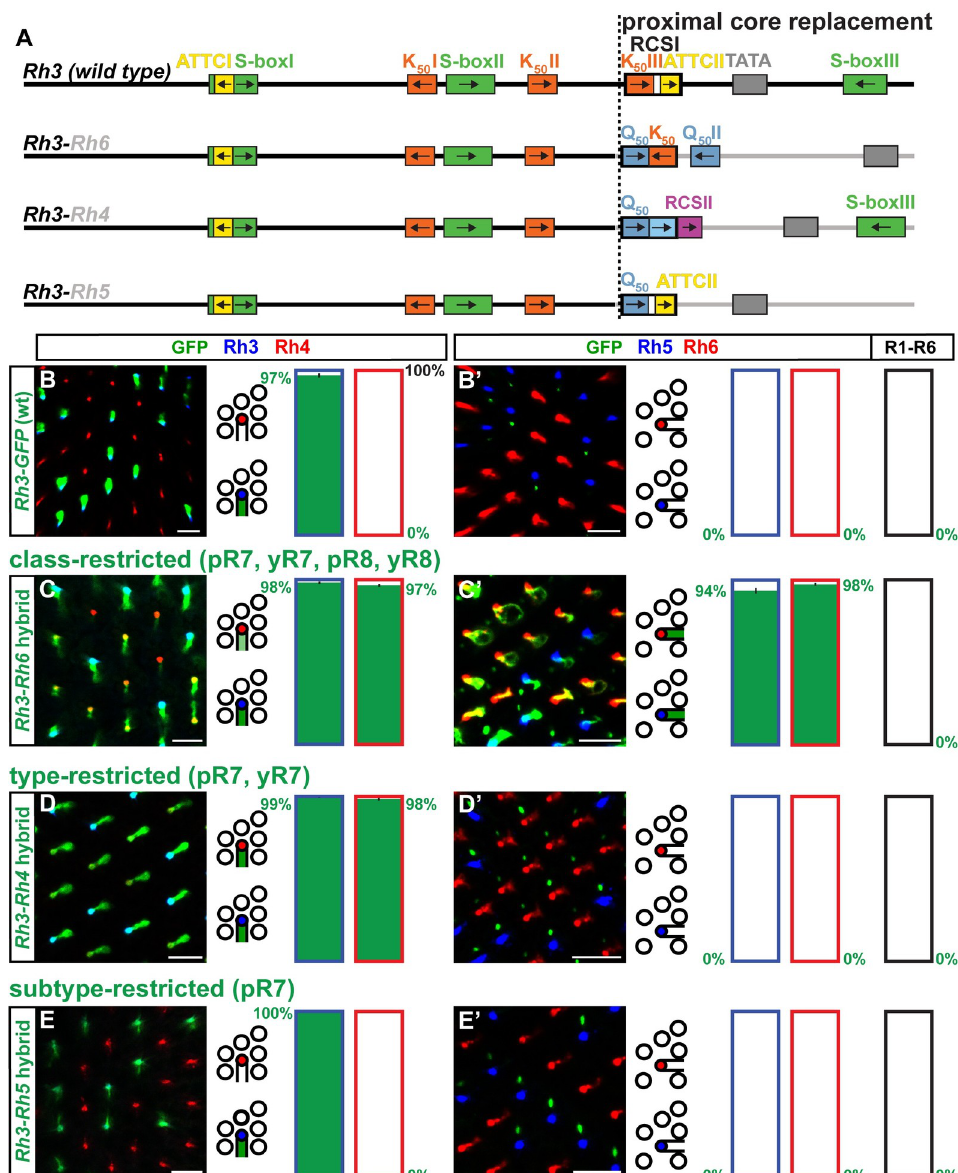
Fig 6. Novel motif combinations yield a series of progressively restricted expression patterns. (A) Schematic comparison of wild type Rh3 promoter and hybrids of the distal Rh3 promoter combined with the proximal core promoters of Rh4 , Rh5 , or Rh6 . Note in the proximal region the shared K 50 motif within the Rh6 RCSI and the ATTCII motif at the same position within the Rh5 RCSI, as well as the same spacing of the Rh5 RCSI and the TATA box. The dotted vertical line indicates the break/fusion point of the hybrids. (B)—(E) Wild type vs . hybrid promoters driving GFP reporter expression (green) in the R7 layer. Rh3 (blue) labels pR7s and Rh4 (red) labels yR7s. Bar graphs show GFP co- expression in the Rh3 or Rh4 subset, respectively. (B’)—(E’) Wild type reporter vs . hybrid promoter driving GFP reporter expression (green) in the R8 layer. Rh5 (blue) labels pR8s and Rh6 (red) labels yR8s. Bar graphs show GFP co- expression in the Rh5, Rh6, or R1-R6 subset. Green numbers indicate the mean percentage of GFP co-expressing photoreceptors, error bar represents standard error of the mean. (B) and (B’) The wild type Rh3 promoter drives subtype-specific GFP expression in the pR7/Rh3 subset. Green staining in (B’) is from the axons of pR7s that traverse the R8 layer. N = 18 retinas and n = 1,188 R7s for (B); N = 11 retinas, n = 958 R8s and 5,748 R1-R6 PRs for (B’). (C) and (C’) The Rh3 - Rh6 hybrid drives photoreceptor class-restricted GFP expression in all ‘inner’ photoreceptors, i.e. both the R7 and R8 photoreceptor types (pR7s, yR7s, pR8s, and yR8s). N = 10 retinas and n = 1,307 R7s for (C); N = 12 retinas, n = 872 R8s and 5,232 R1-R6 PRs for (C’). (D) and (D’) The Rh3 - Rh4 hybrid drives photoreceptor type-restricted GFP expression in both R7 subtypes (pR7s and yR7s). GFP signal in (D’) is from traversing R7 axons. N = 12 retinas and